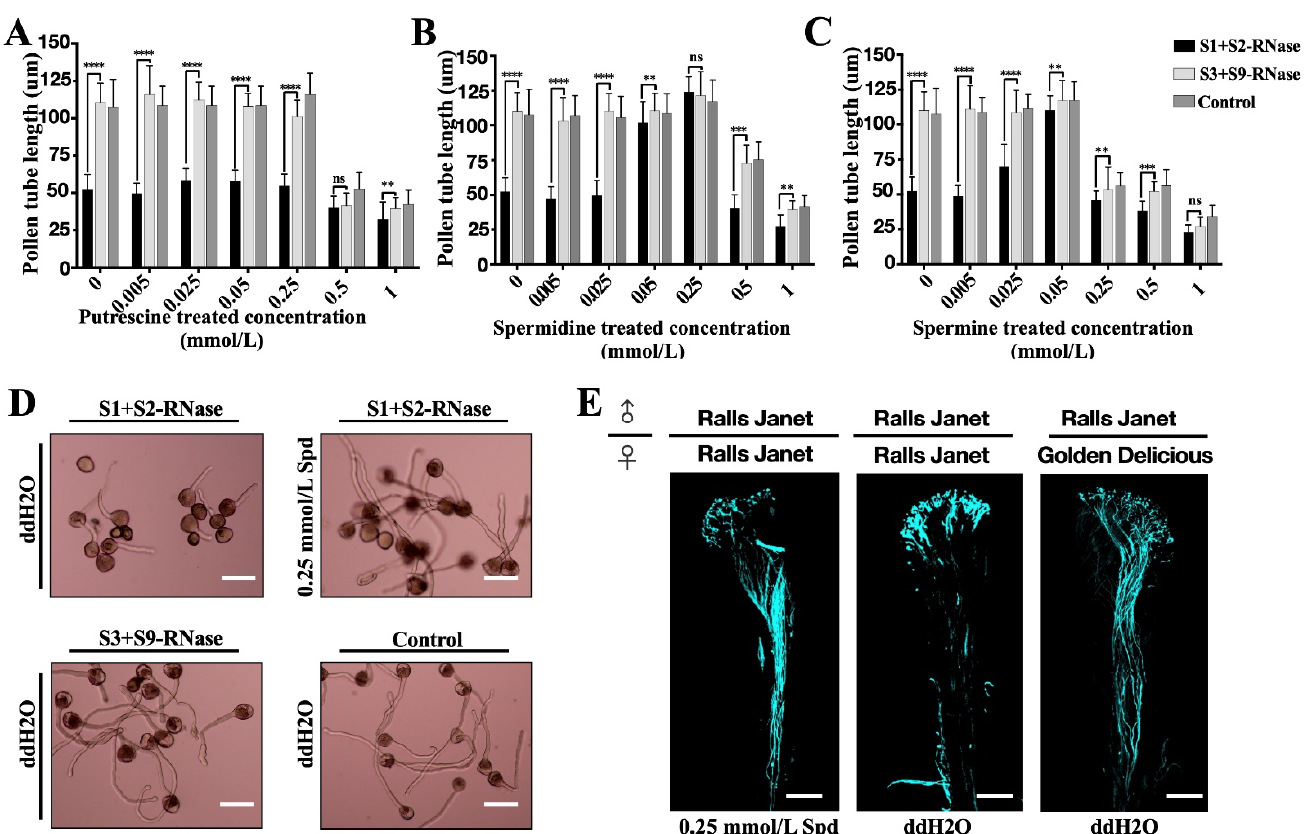
Figure 4. Effects of exogenous polyamines on self-S-RNase tolerance of pollen tubes. Effects of exogenous polyamines on pollen tube elongation. ( A – C ) After putrescine, spermidine, and spermine treatment, the effect of S-RNase on pollen tube length. Data show means ± SD of three biological replicates. Per treatment at least 50 pollen tubes. ( D ) Upper: Pollen tube germination after self-S-RNase was added (left), Pollen tube germination after self-S-RNase and 0.25 mmol/L were added (right), Lower: Pollen tube germination after non-self-S-RNase was added (left) and only pollen germinated in the medium (right). ( E ) After 0.25 mmol/L spermidine treated and control (ddH 2 O) treated, aniline blue staining of ‘Ralls Janet’ pollen on ‘Ralls Janet’ pistil and ‘Ralls Janet’ pollen on ‘Golden Delicious’ pistil for 72 h, Scale bars represent 550 μ m. **, p < 0.01; ***, p < 0.001; ****, p < 0.0001 by Tukey’s multiple comparisons test.